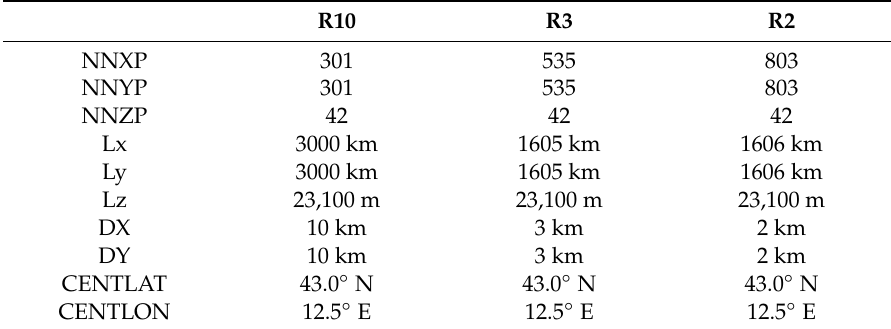
Figure 5. Model domains used for the simulations. The extension of R2 and R3 are similar (about 1600 km). Table 1. Basic parameters of the RAMS@ISAC grids R10, R3, and R2, corresponding to the two configurations C1 and C2. C1 uses R10 and R3, C2 uses R10 and R2. NNXP and NNYP represent the number of grid points in the WE and NS directions, respectively. NNZP is the number of vertical levels. DX and DY are the grid spacing sizes in the WE and SN directions. Lx, Ly, and Lz are domain extensions in NS, WE, and vertical directions. CENTLON (longitude of the grid center) and CENTLAT (latitude of the grid center) are the coordinates of the grid centers.